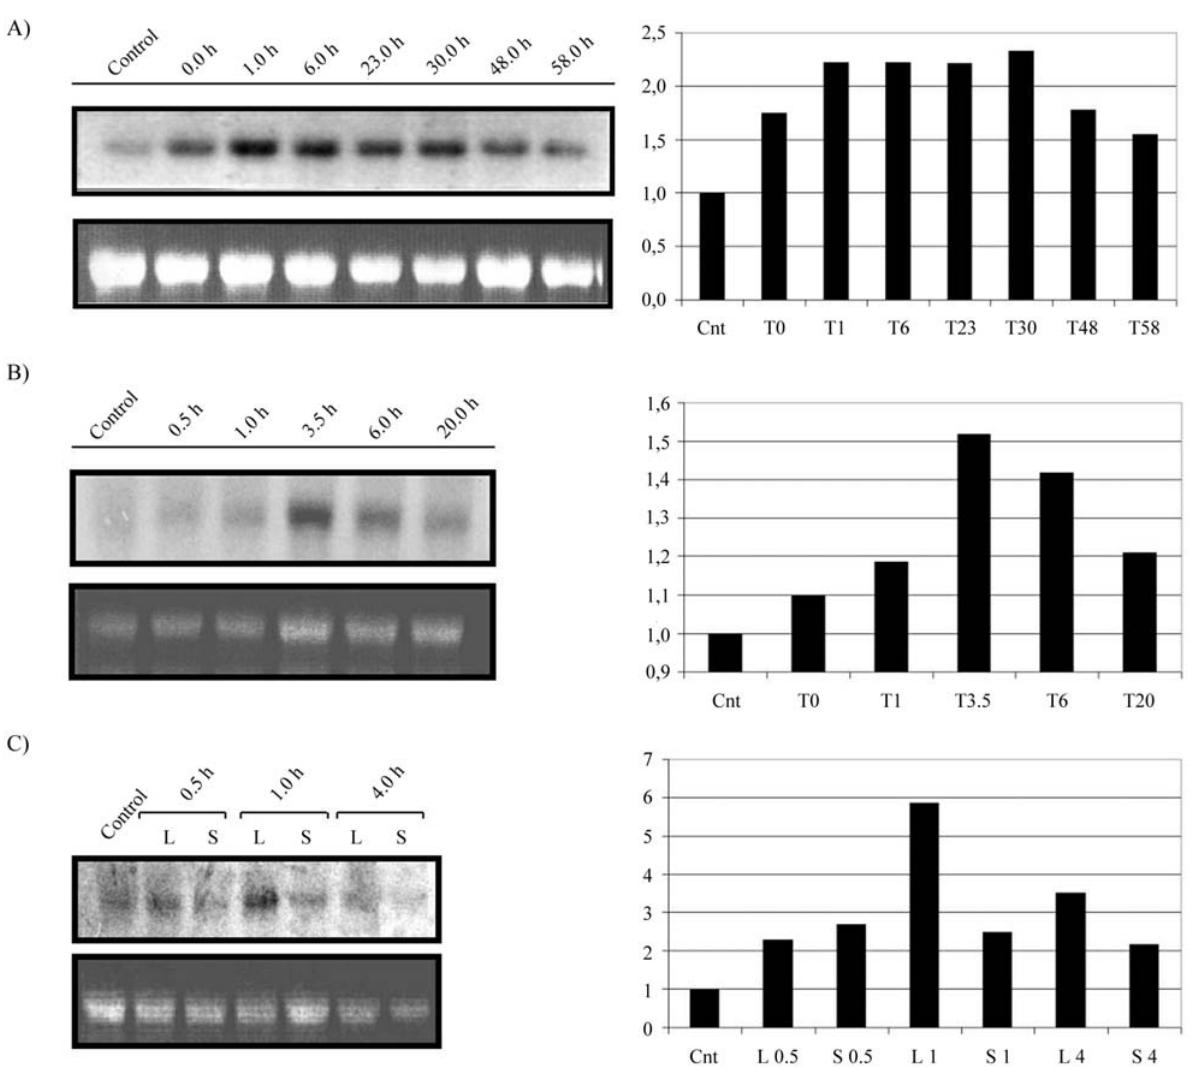
Figure 1 - AtchitIV transcripts accumulation in leaves in response to abiotic stress analysed by RNA blot hybridization. RNA from leaves of stressed plants collected at different time points, shown in hours , after the onset of treatments and RNA from leaves of control plants cultivated under normal con- ditions. A) UV irradiation (the 0.0 point represents the transcript levels just after the end of treatment); B) Salicylic acid treatment; C) Wounding treat- ment: (L) and (S) represent the local and systemic wounding leaves. The AtchitIV cDNA was used as a probe. Histograms correspond to the quantitative ratio between the autoradiographic signal and the ethidium bromide staining of RNA samples (bottom